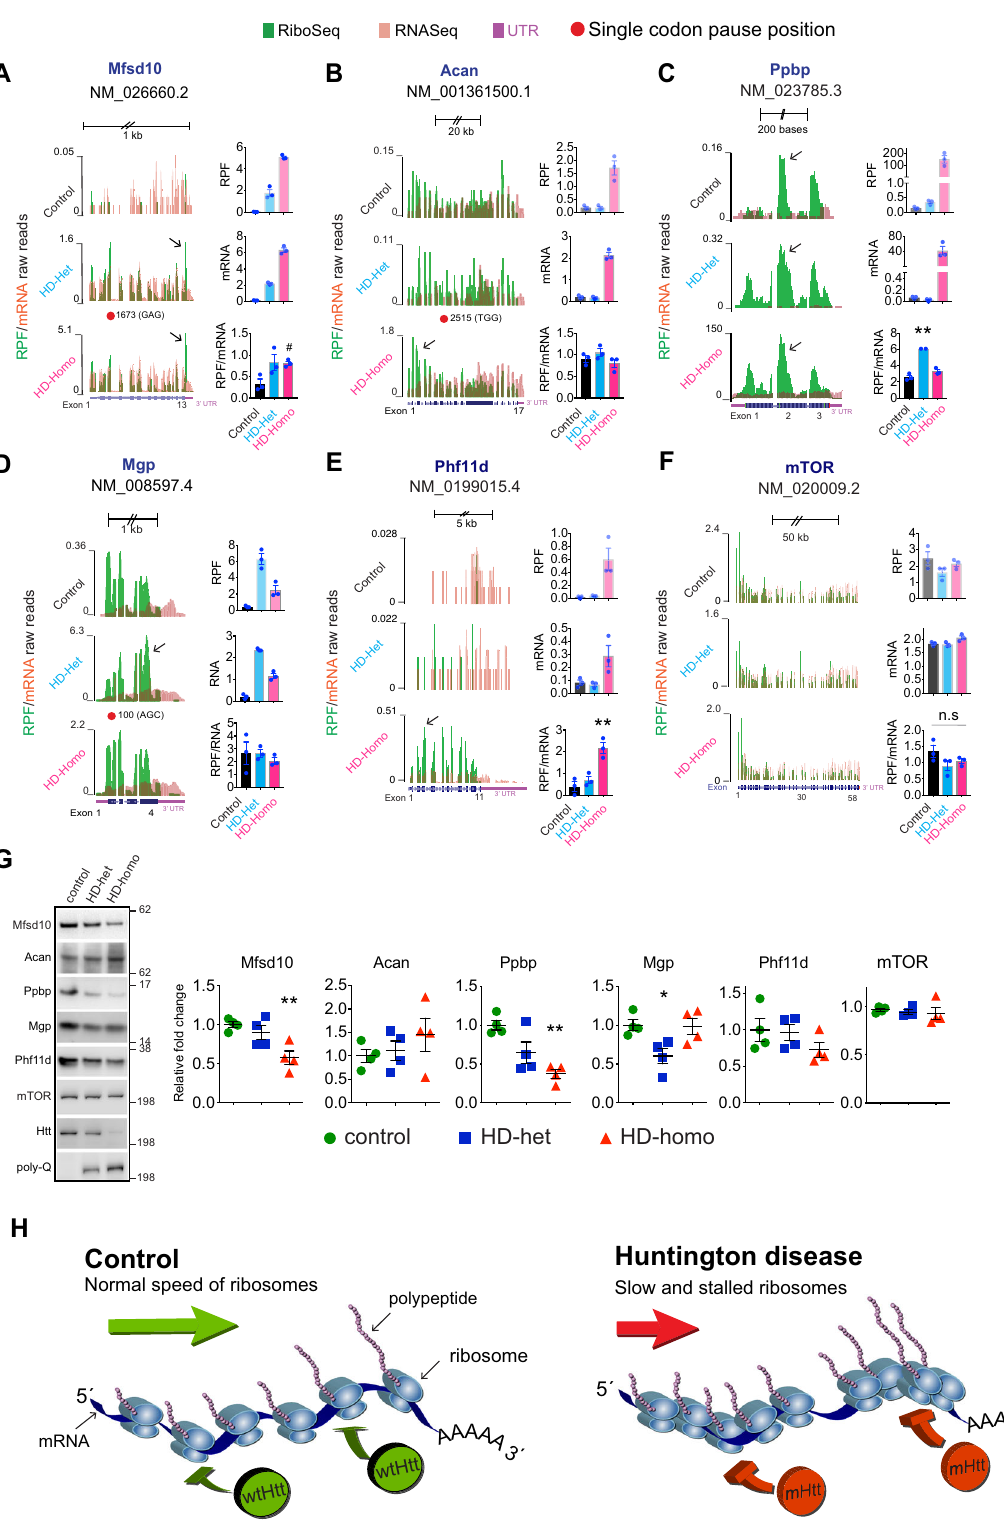
mHtt might promote translational abnormalities were not revealed by these previous